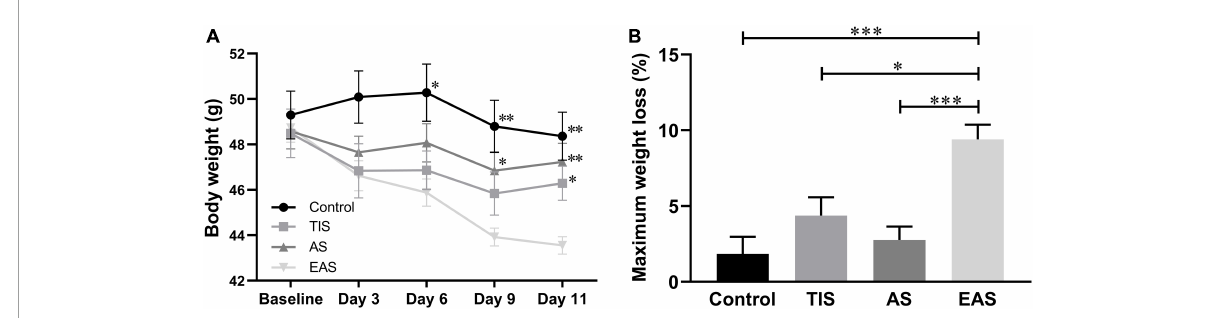
FIGURE2 Body weight changes after surgery. (A) There was a significant weight loss in mice that underwent extended abdominal surgery on postoperative days 6, 9, and 11. ∗ , ∗∗ , ∗∗∗ vs. group EAS. (B) On day 11, after all behavior tests were completed, group Ex-Abdo mice lost significantly more weight than the other three groups of mice. ∗ , ∗∗∗ vs. group EAS. Data represent mean ± SEM ( n = 9–12 per group). ∗ P < 0.05; ∗∗ P < 0.01; ∗∗∗ P < 0.001.